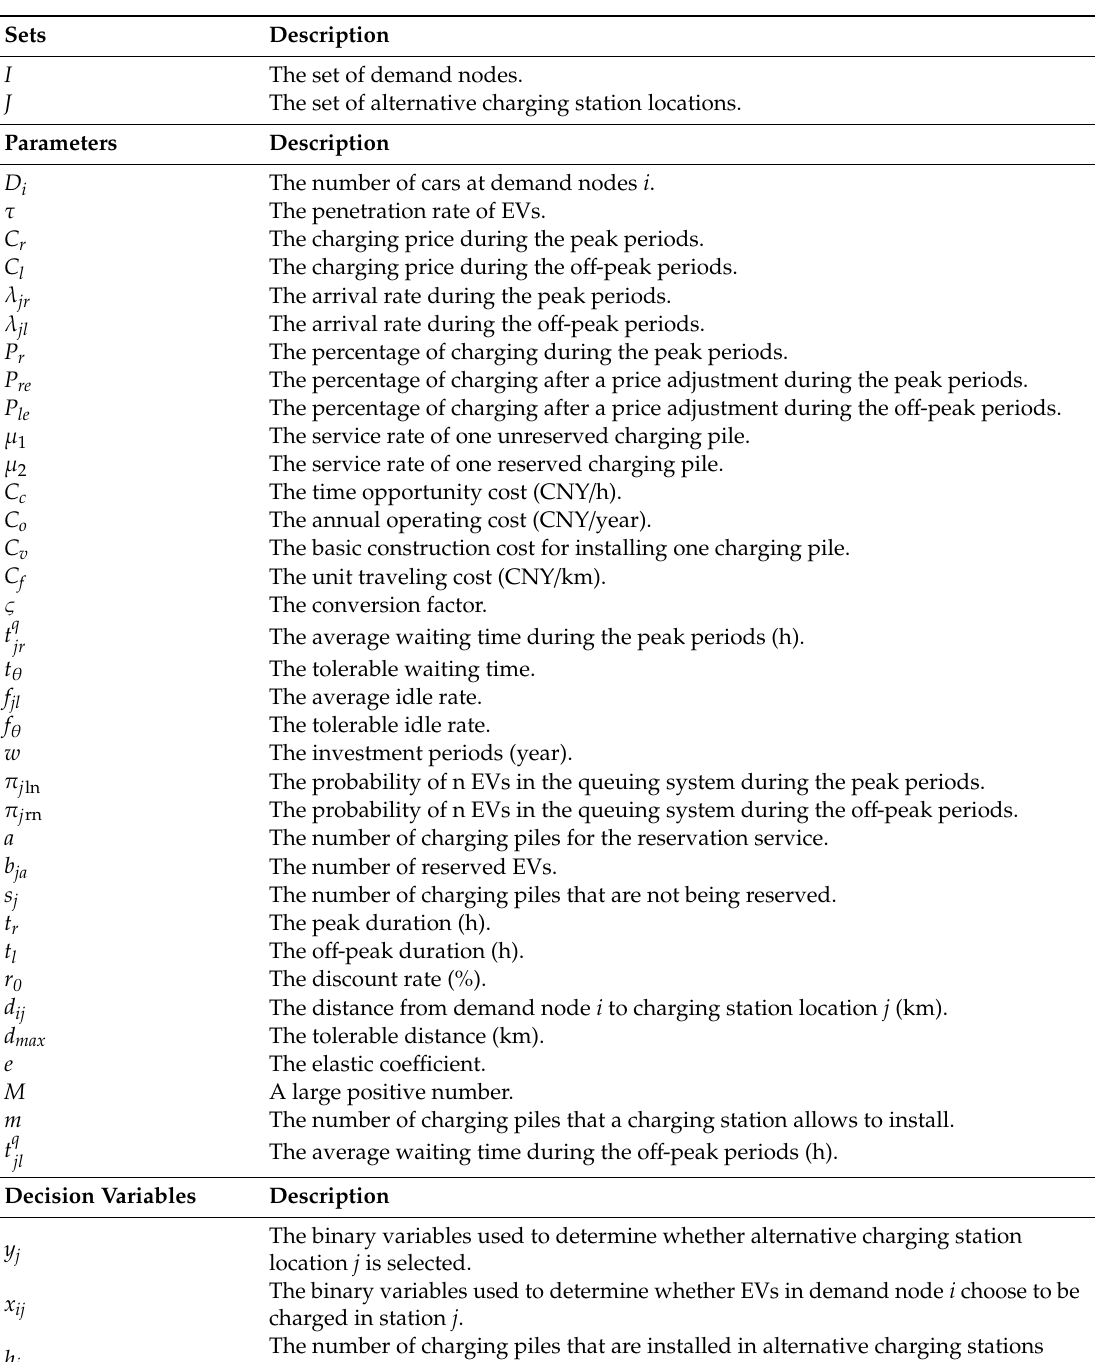
Table 1. Notations used in this